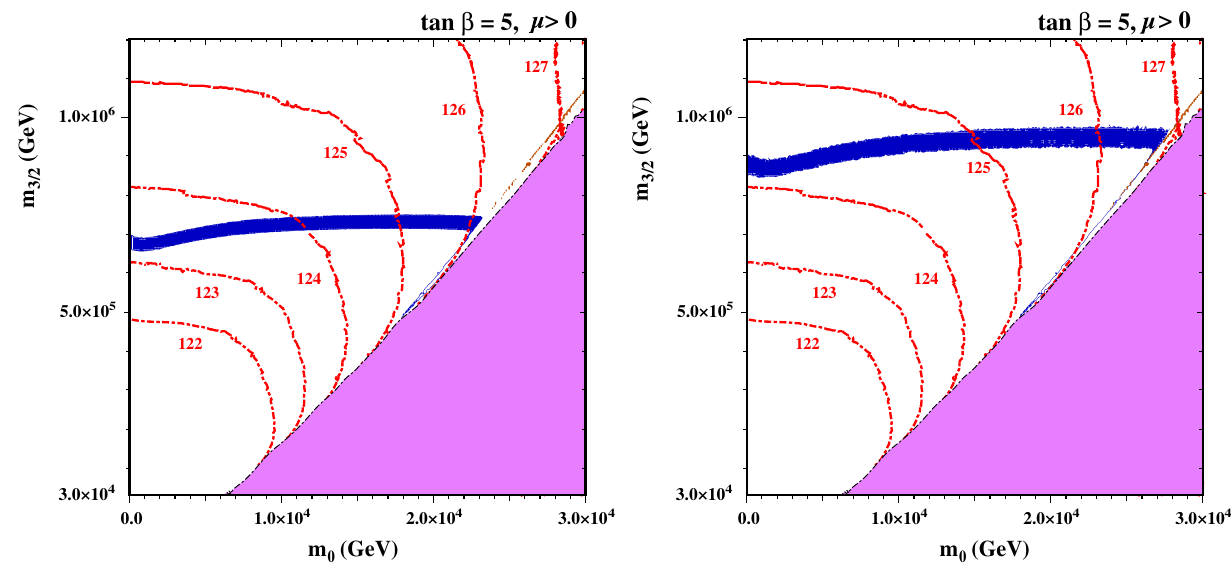
˜ χ 0 LSP density falls within the range of the CDM density indicated by 1 Planck and other experiments in the dark blue shaded bands . Contours of M h calculated using FeynHiggs 2.11.3 (see text) are shown as red dashed lines